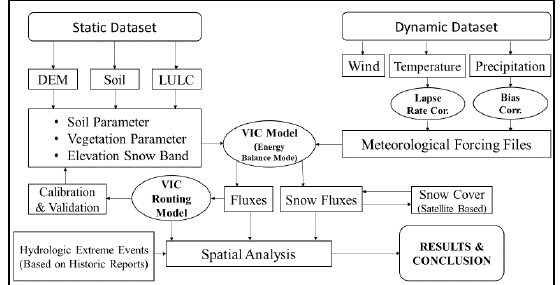
Figure 4. Overall approach for hydrological